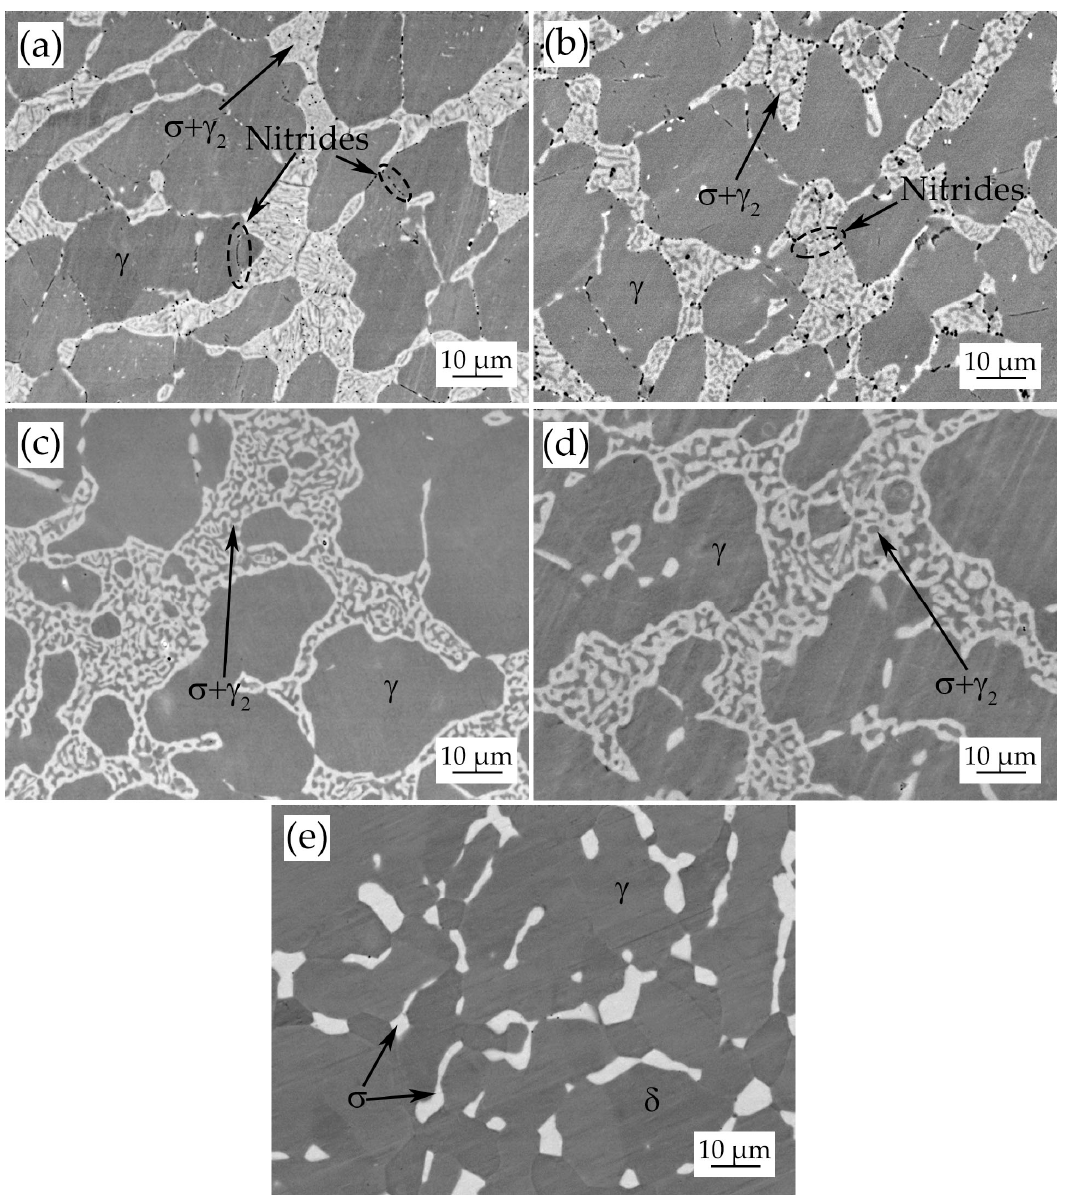
Figure 5. Microstructure after 24 h heat treatment at: 850 °C ( a ), 900 °C ( b ), 950 °C ( c ), 1000 °C ( d ) and 1050 °C ( e ).